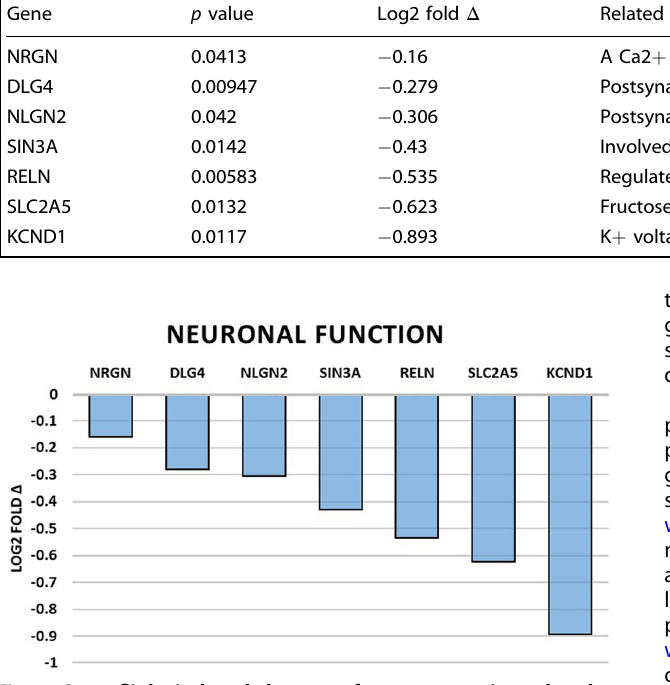
Fig. 1 Space fl ight-induced changes of gene expression related to neuronal function. Bar graph summarizing log2 fold-changes of signi fi cantly differentially expressed genes (DEG) ( p < 0.05) in the fl ight (FLT) group compared to the ground control (GC) group in genes directly related to neuronal function. N = 6/group. p values are calculated using one-way analysis of variance (ANOVA) and Tukey ’ s HSD (honestly signi fi cant difference) test. Source data are provided as a Source Data fi le.